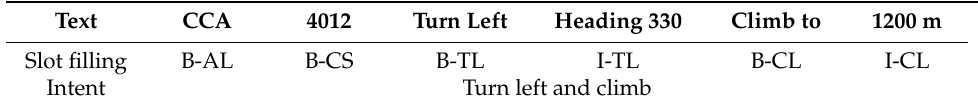
Table 5. An example of language understanding samples